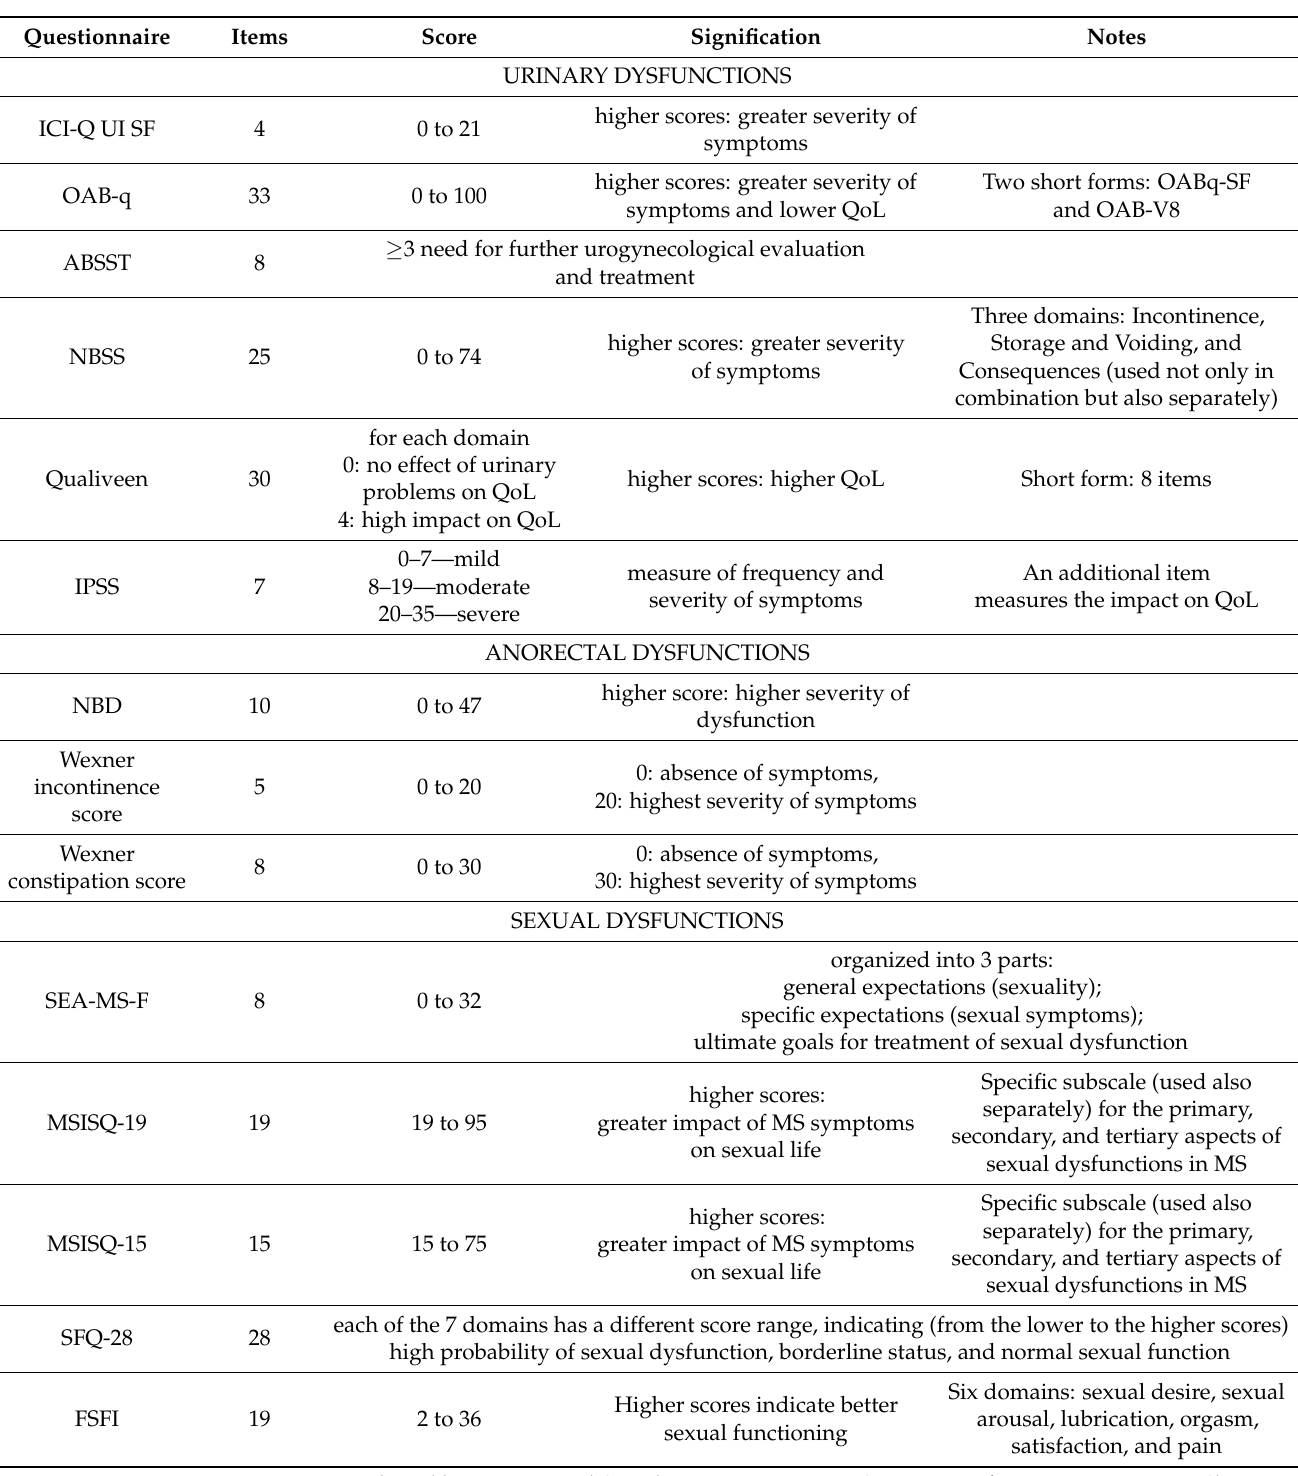
Table 1. Patient-reported outcome questionnaires for sphincteric and sexual dysfunction.